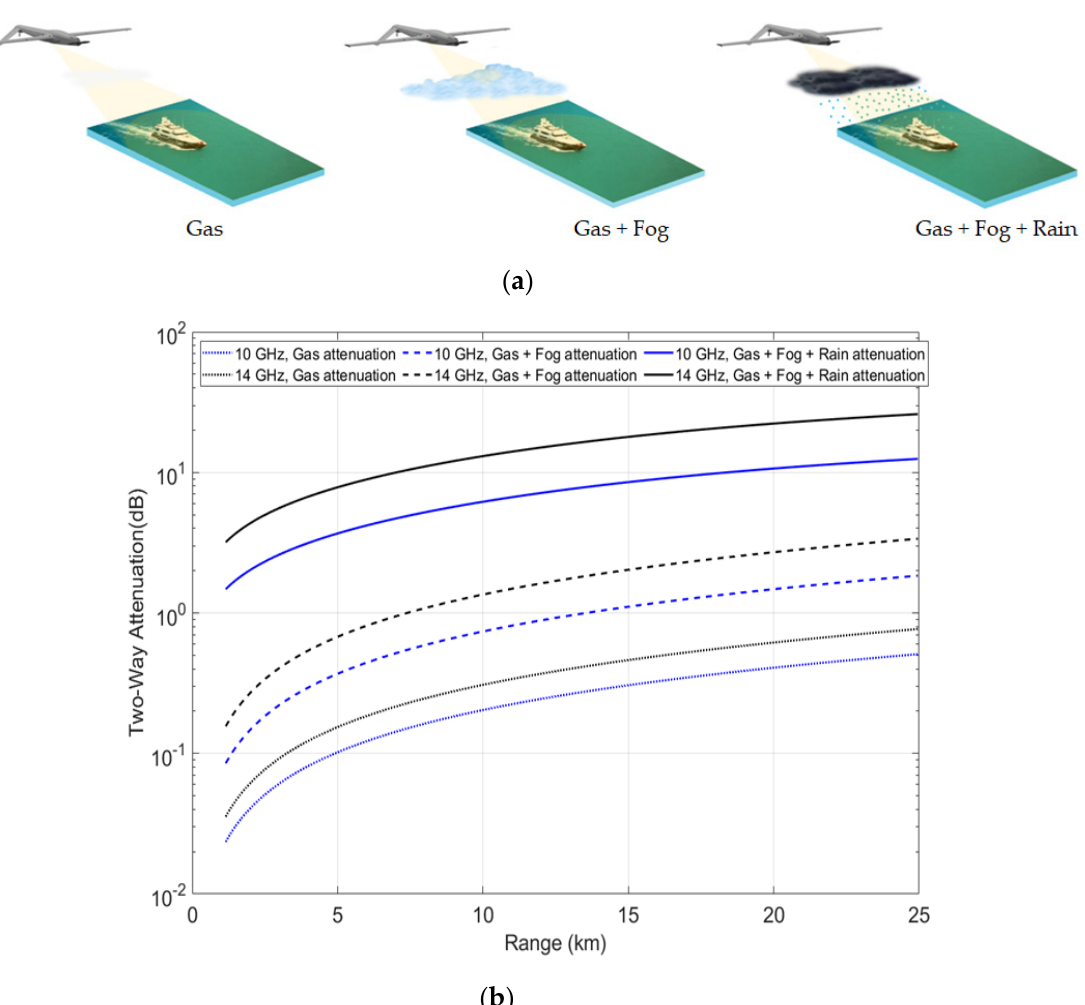
Figure 4. ( a ) Marine observation in different weathers; ( b ) radar signal attenuation versus detection range.